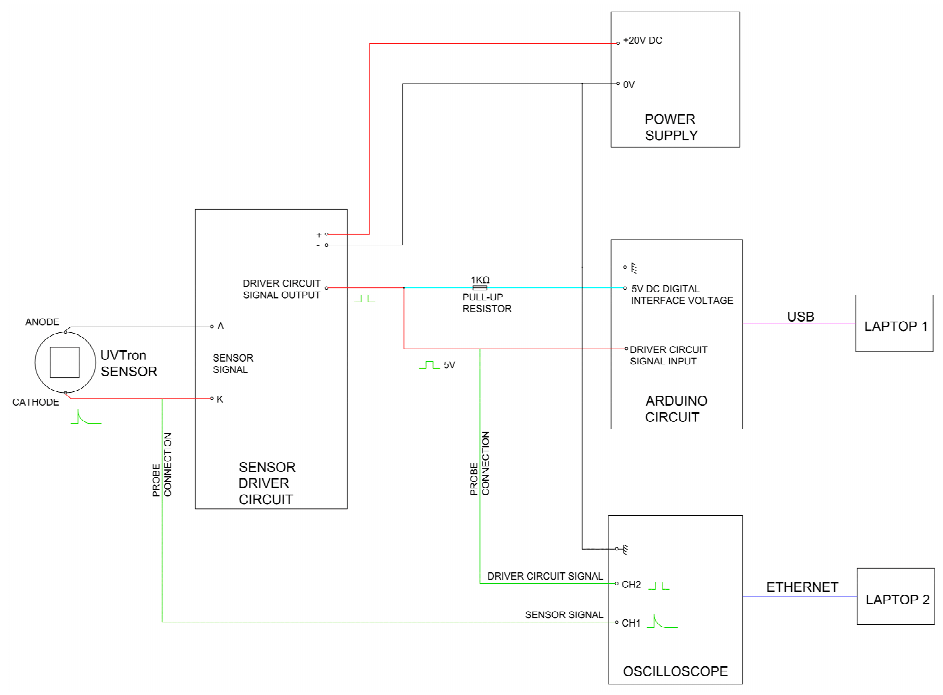
Figure 1. Schematic of equipment set-up.